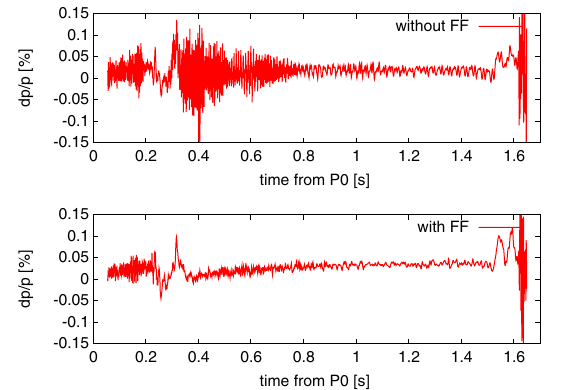
FIG. 15. Typical beam loss monitor signal in the arc sections without and with feedforward.